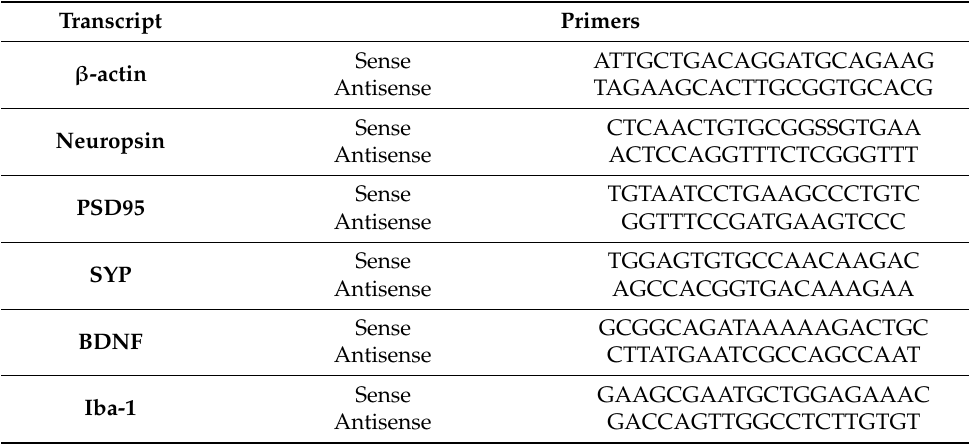
Table 1. RT-qPCR primers in 5 (cid:48) –3 (cid:48) direction.